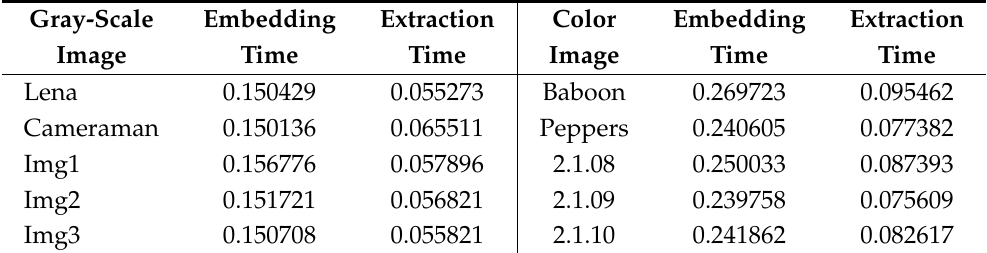
Table 9. Embedding and extraction time (in seconds) of different test cover images.